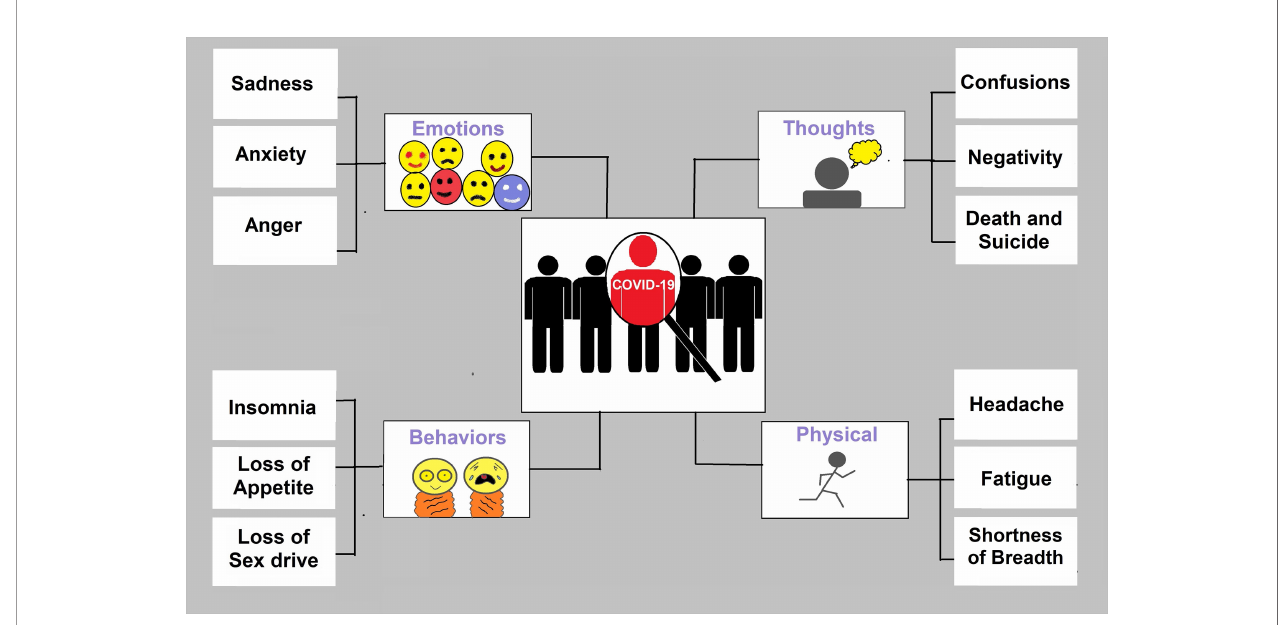
FIGURE 5 | Symptoms of depression for COVID-19 patients. COVID-19 has changed emotions, behaviours, thoughts, and physical condition. Anxiety and stress are the common outcomes in